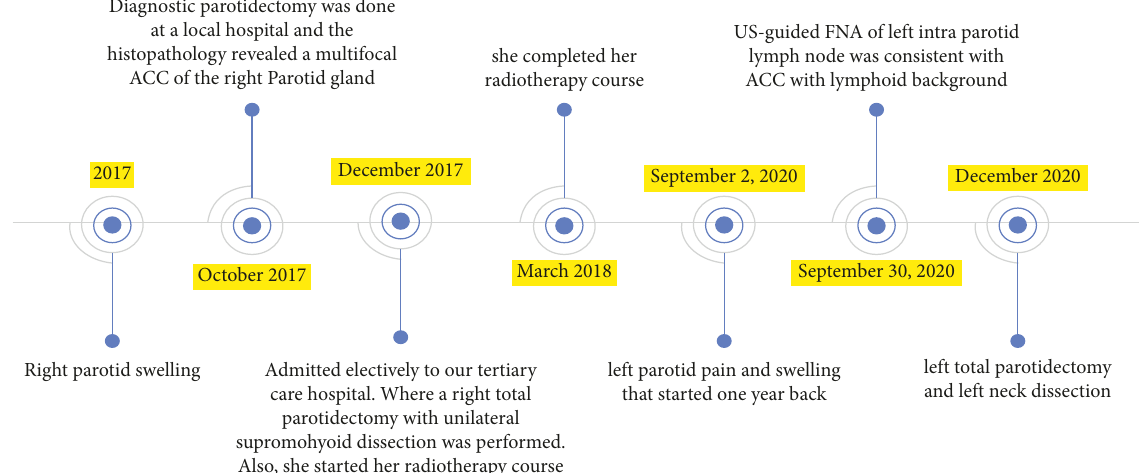
Figure 9: Symptoms, investigations, radiotherapy course, and